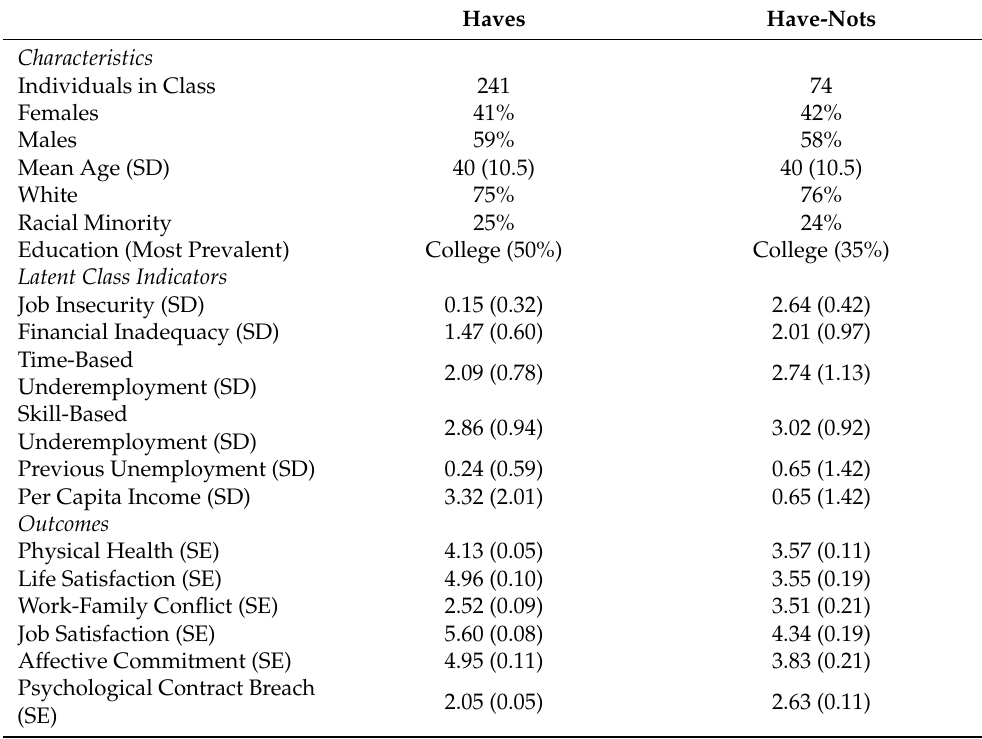
Table 4. Latent classes descriptive